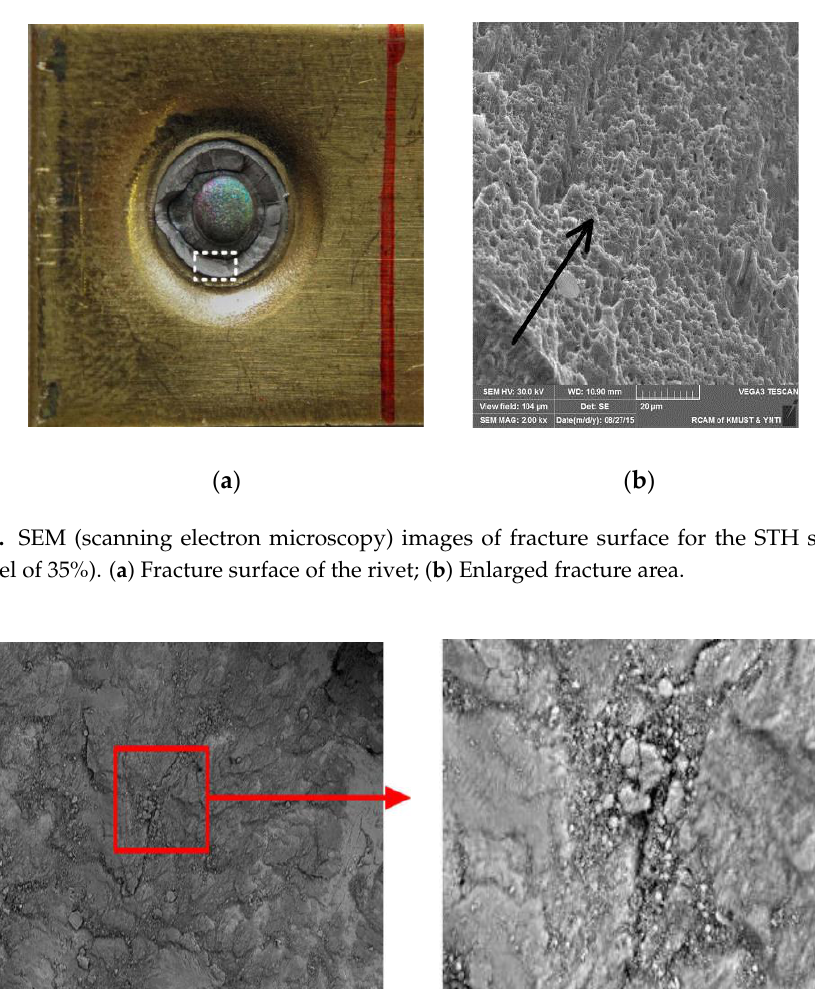
Figure 9. An example of SEM analysis of oxide debris in the STH specimens (load level of 35%). ( a ) Fretting debris; ( b ) Enlarged fretting debris.